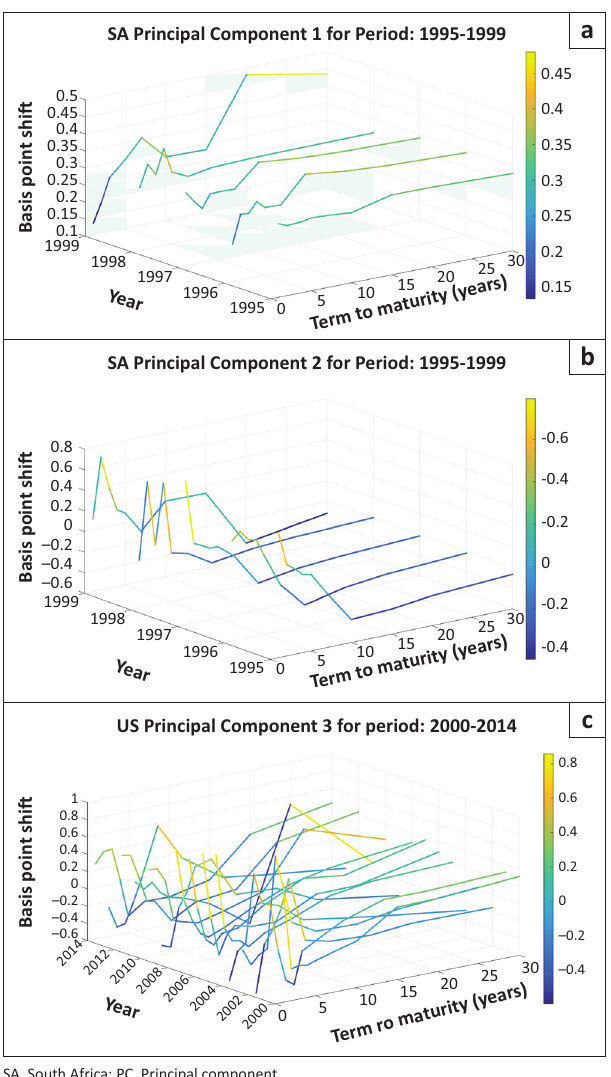
SA, South Africa; PC, Principal component. FIGURE 13: Three-dimensional representation of annual South African principal components for the period 2000–2014. SA, South Africa: (a) SA annual PC1; (b) SA annual PC2; (c) SA annual